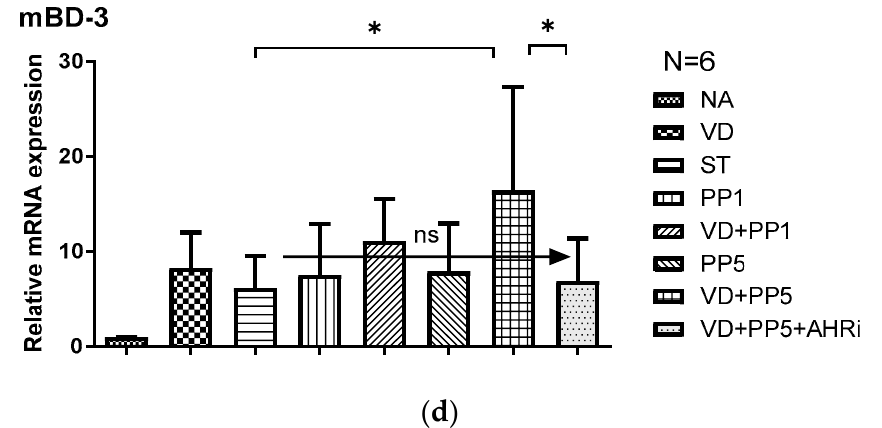
Figure 2. The involvement of AhR in the synergistic effects of PP on the VD3-regulated cecal proinflammatory cytokines and AMP in Salmonella colitis mice. Mice were treated or infected as in Materials and Methods and divided into the following groups: Control (NA), ST ( S .Tm infected), VD (VD3 and S .Tm infected), PP1 or PP5 (1% or 5% propionate and S .Tm infected), VD + PP1 (combination of VD3 and 1%propionate plus S .Tm infected), VD + PP5 (combination of VD3 and 5% propionate plus S .Tm infected), VD + PP5 + AHRi (combination of VD3 and 5% propionate plus S .Tm infected and AhR inhibitor). Total RNA was extracted from the cecal tissues. IL-1 β ( a ), IL-6 ( b ), TNF- α ( c ), and mBD-3 ( d ) mRNA expressions were analyzed using quantitative RT-PCR. Values are measured as fold increase compared to the level of control mice. The data shown are means ± the SEM ( n = 6 mice/group). (* p < 0.05, *** p < 0.001, ns: not significant).